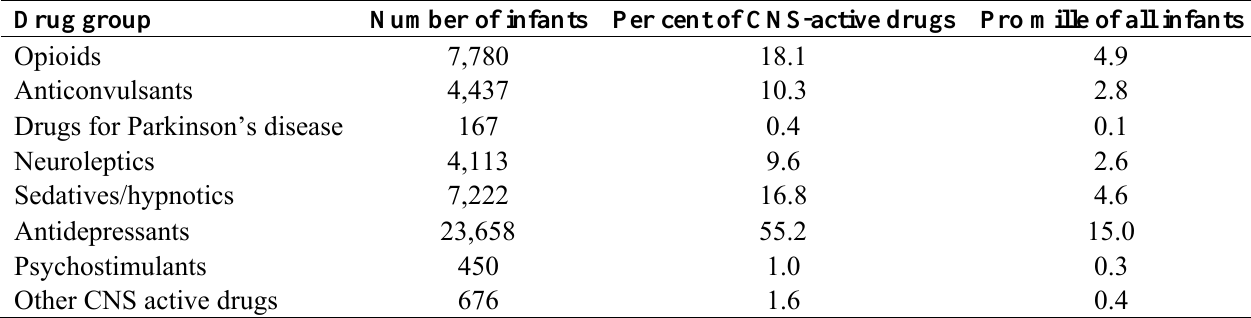
Table 1. Overview of groups of CNS active drugs used in early pregnancy. Number of exposed infants. Drug